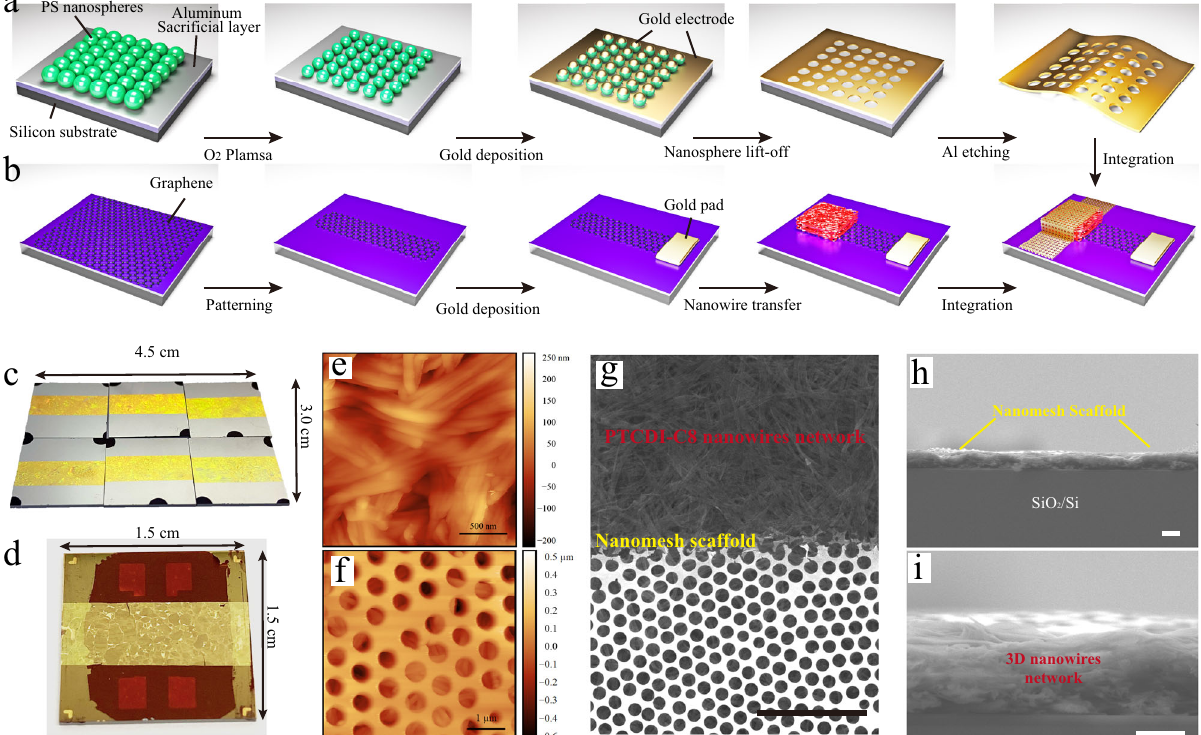
Fig. 2 Design of a vertical fi eld-effect transistor (VFET) with nanomesh scaffold. a Fabrication process fl ow for the hexagonal hole array nanomesh scaffold through nanosphere lithography, O 2 plasma etching and transfer process. Nanosphere was transferred onto an Al-deposited SiO 2 /Si wafer. The geometrical parameters of the resulting nanostructure could be tuned by the diameter of the polystyrene nanospheres and the etching dose of the oxygen plasma. The aluminum layer was removed by solution etching, and the nanomesh scaffold was then transferred onto the targeted substrate. b Graphene/ nanowires network fabrication procedure. The transferred monolayer graphene was patterned by photolithography and O 2 plasma to form the bottom source electrode. PTCDI-C8 nanowires network was transferred on the graphene layer through a vacuum-assisted stamp method. The fl oating nanomesh scaffold was then transferred directly onto the PTCDI-C8 network as the top drain electrode. c Photograph of a large-area nanomesh scaffold on